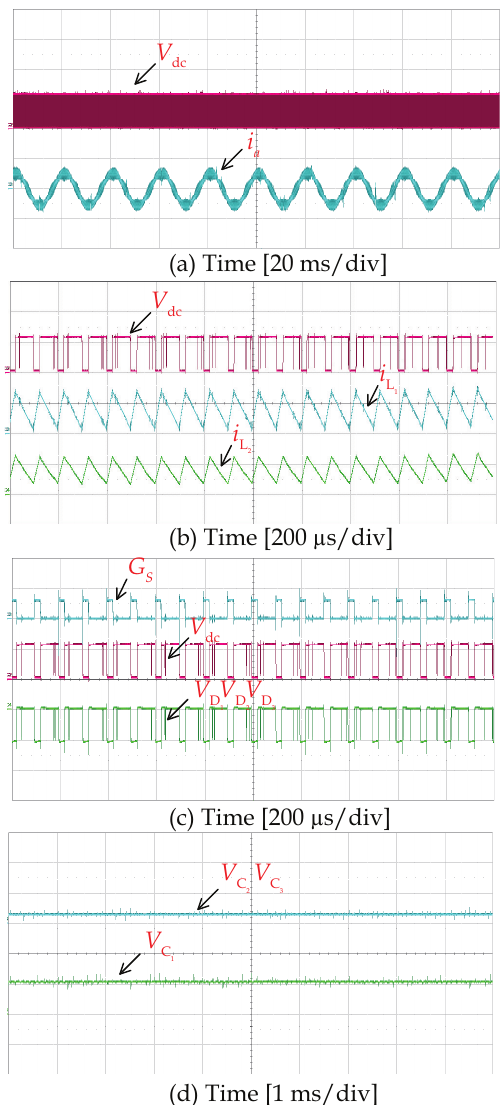
Figure 12. Experimental results of the proposed S-qZSI: ( a ) DC-link voltage V dc [100 V/div] and output phase-a current i a [2 A/div], ( b ) DC-link voltage V dc [100 V/div] and inductor currents i L [5 A/div], ( c ) gate signal G S [20 V/div], DC-link voltage V dc [100 V/div] and diode voltages V D V D [100 V/div], and (d) capacitor voltages V C 3